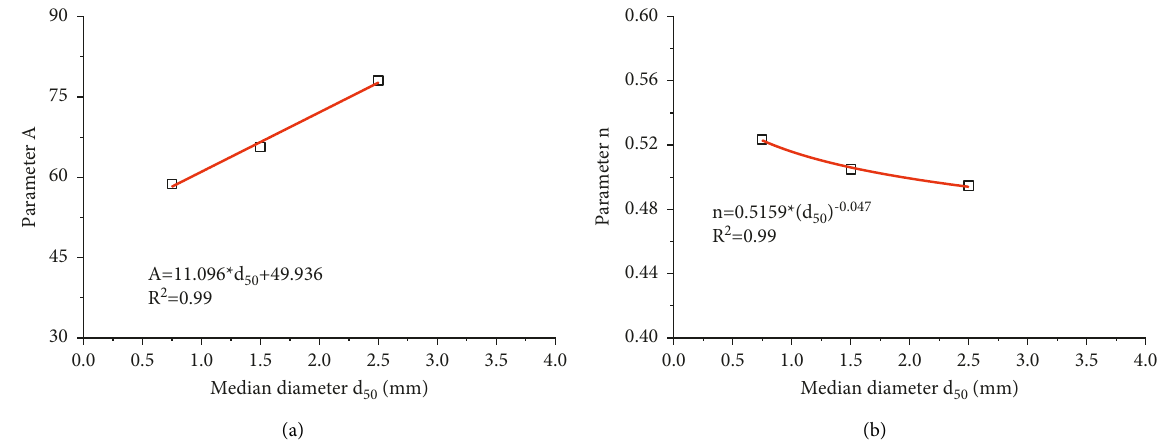
Figure 13: The median diameter and parameters associated with experienced equations. (a) Parameter A and (b) parameter n